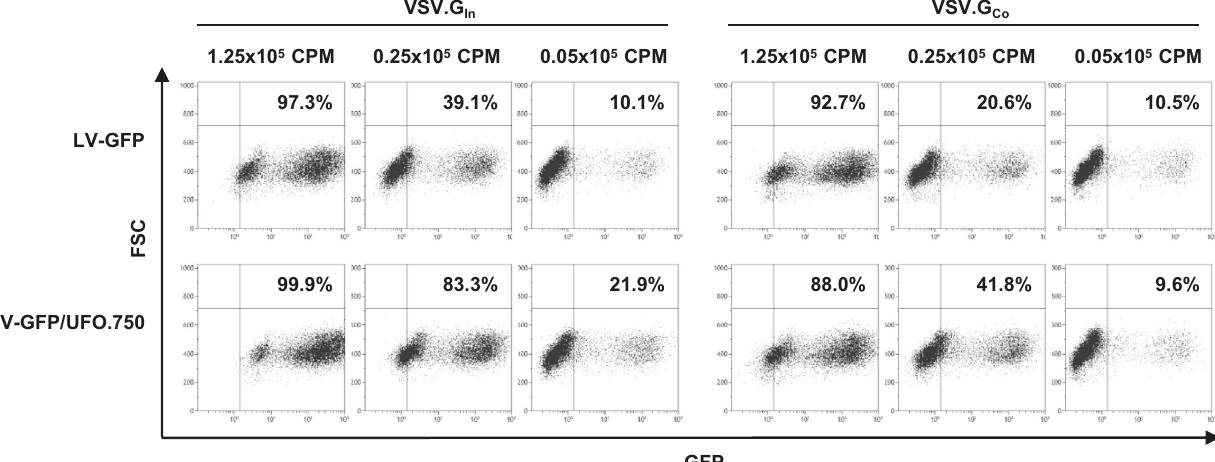
Fig. 5 Pseudotyping ConSOSL.UFO.750 on IDLV surface does not interfere with VSV.G-mediated transduction ef fi ciency. Top panels: Flow cytometry analysis (FSC vs GFP expression) of 293T Lenti-X cells transduced with LV-GFP pseudotyped with VSV.G serotypes from Indiana (VSV. G In , left panels) or Cocal (VSV.G Co , right panels). Bottom panels: Flow cytometry of 293T Lenti-X cells transduced with LV-GFP pseudotyped with VSV.G serotypes as above and with ConSOSL.UFO.750 (LV-GFP/UFO.750). Percentage of positive cells is indicated. Shown are results from one representative of n = 3